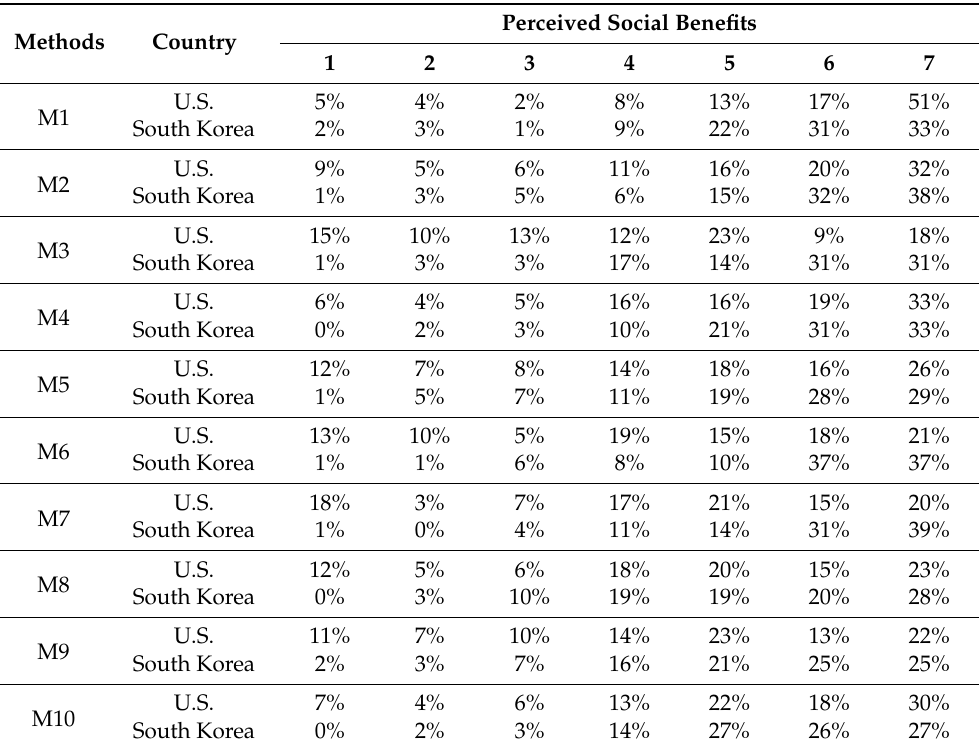
Table A3. Frequency of the perceived social benefits for 10 methods (U.S. and South Korea). Methods